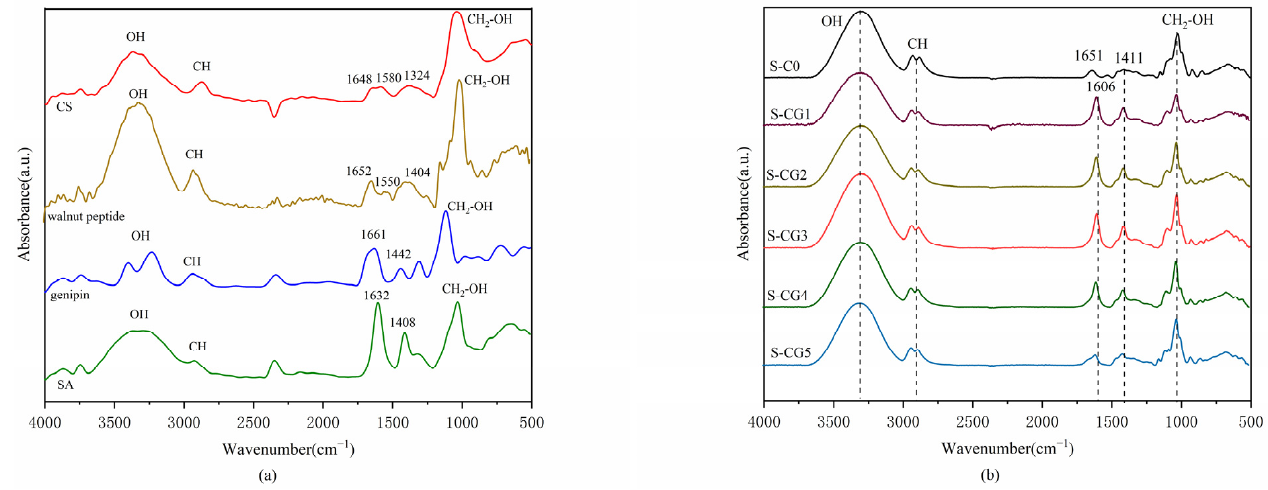
Figure 2. FTIR spectra of raw material ( a ) powders, including CS, walnut peptide, genipin, and SA, and six sample films described in Table 1 ( b ).